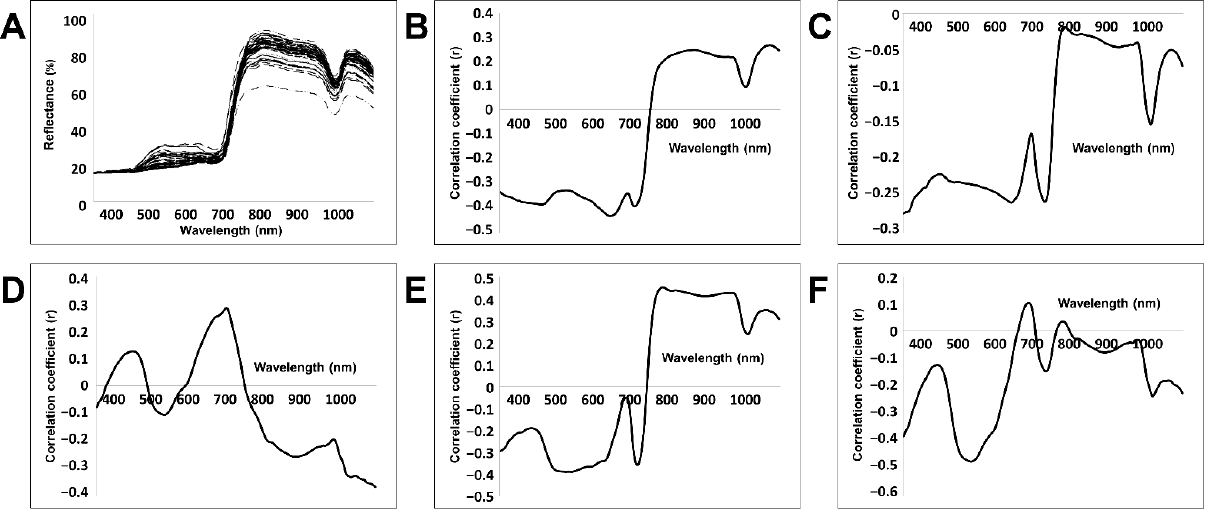
Figure 4. Average spectra ( A ) and correlation coefficient graphs for the contents of the main func- tional components present in leaves of B. juncea (total chlorophylls, ( B ); total carotenoids ( C ); total phenolics ( D ); total glucosinolates ( E ); total anthocyanins ( F )). ( D ); total glucosinolates ( E ); total anthocyanins ( F